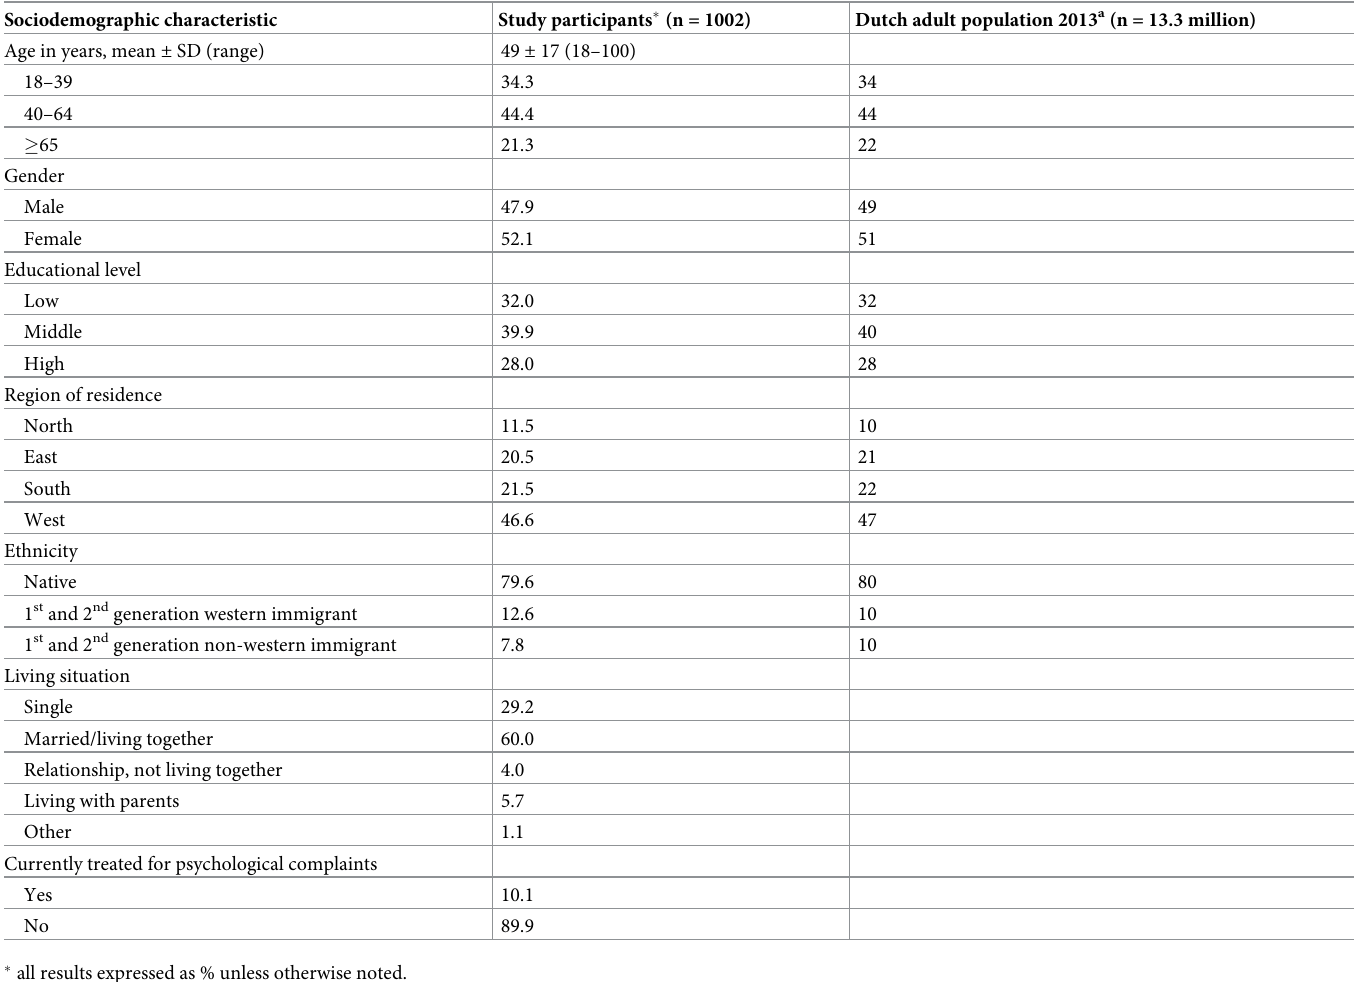
Table 1. Sociodemographic characteristics of participants and the Dutch general